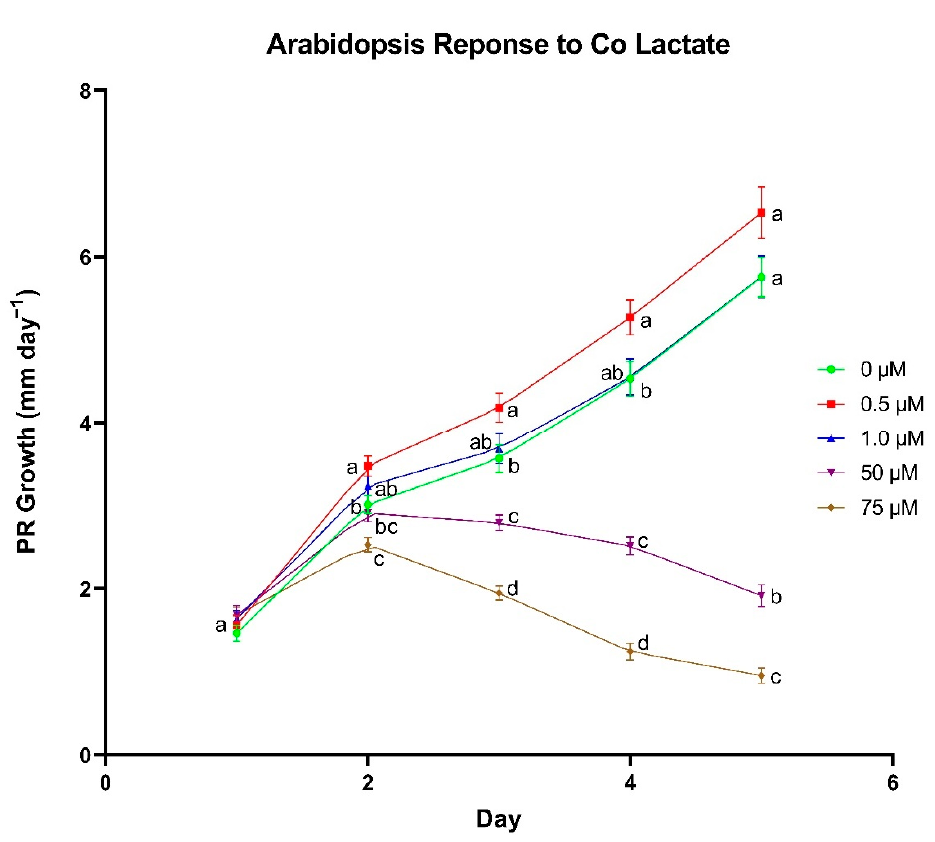
Figure 5. The effect of cobalt (Co) lactate concentration on primary root (PR) growth rate in Arabidopsis thaliana . Differences between means were compared using Tukey’s Honest Significant Difference test, where different letters indicate a statistically significant difference between treatment concentrations in their respective day of growth. Error bars show means ± SE ( n = 40–74).